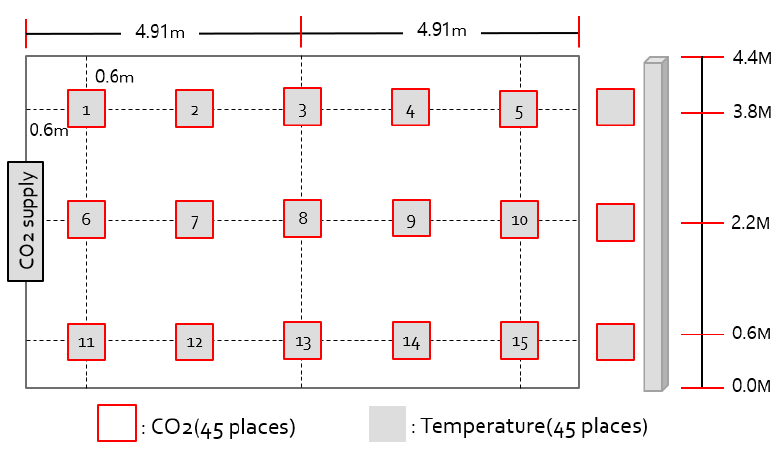
Figure 6. Measurement locations of environmental data inside the greenhouse. Statistical Package for the Social Sciences (IBM, SPSS Statistics 22.0.0.0, New York, NY, USA) was used for statistical analysis and Origin Pro 9.5.5 (OriginLab, Northampton, MA, USA) was used for the data representation as figures. The measured data were analyzed using Sigma Plot (Sigma Plot v10.0, Systat Software Inc., Chicago, IL, USA).